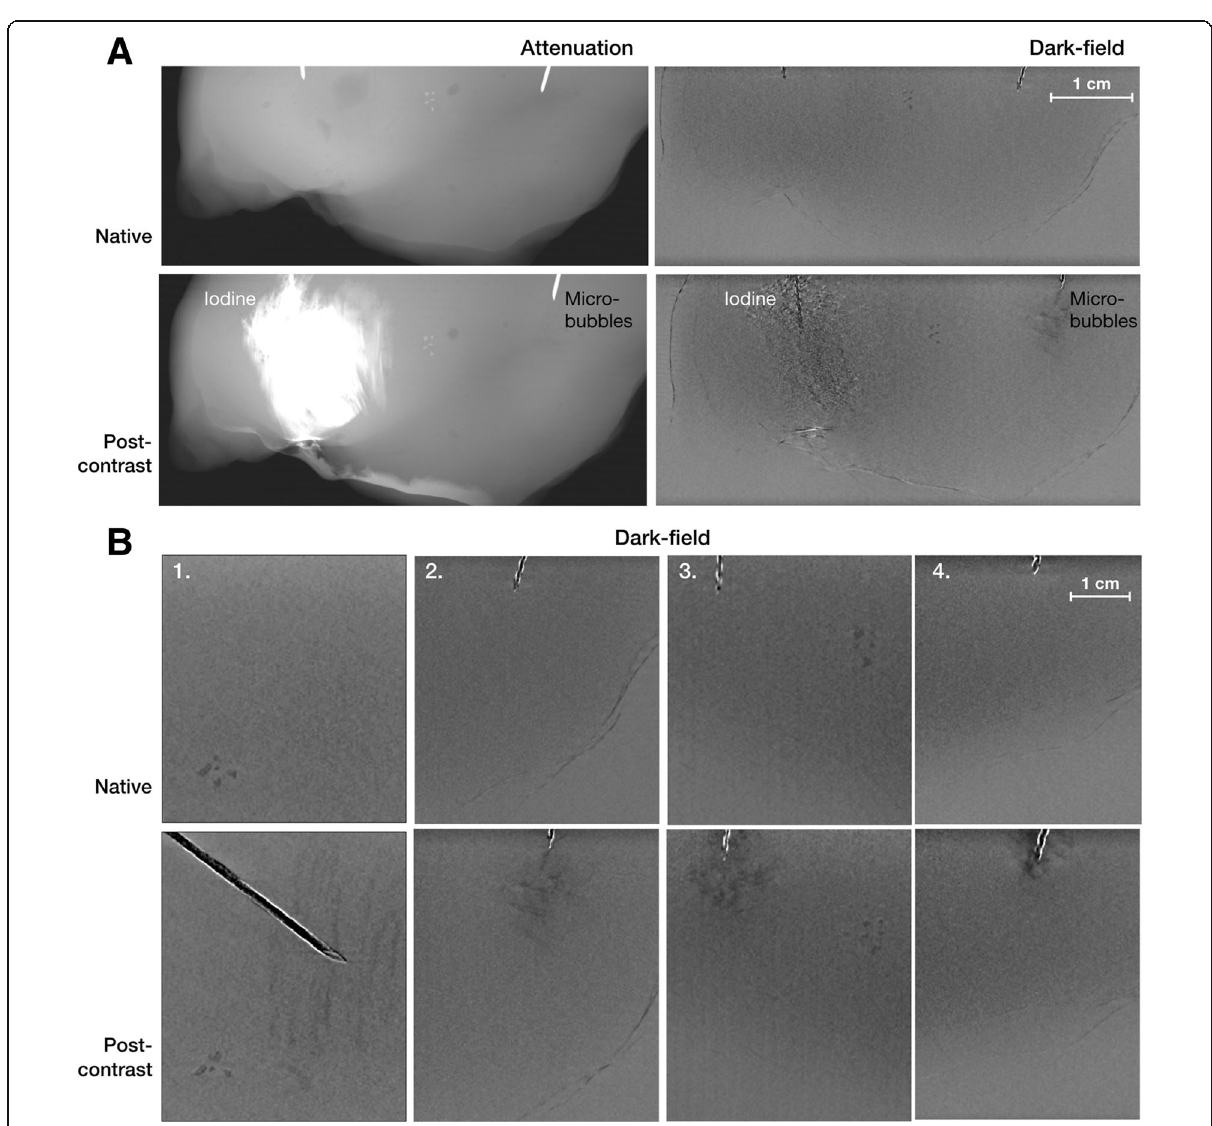
Fig. 2 a Native and post-contrast grating interferometer mammograms of the chicken breast injected with iodine and microbubbles. The iodine is visible in both the attenuation image (left) and in the dark-field image (right), whereas the microbubbles are only visible in the dark-field mode. The egg-shells (centre of the sample) were visible in both the attenuation and the dark-field image. b A display of the dark-field images of all four samples before and after the injection of microbubbles